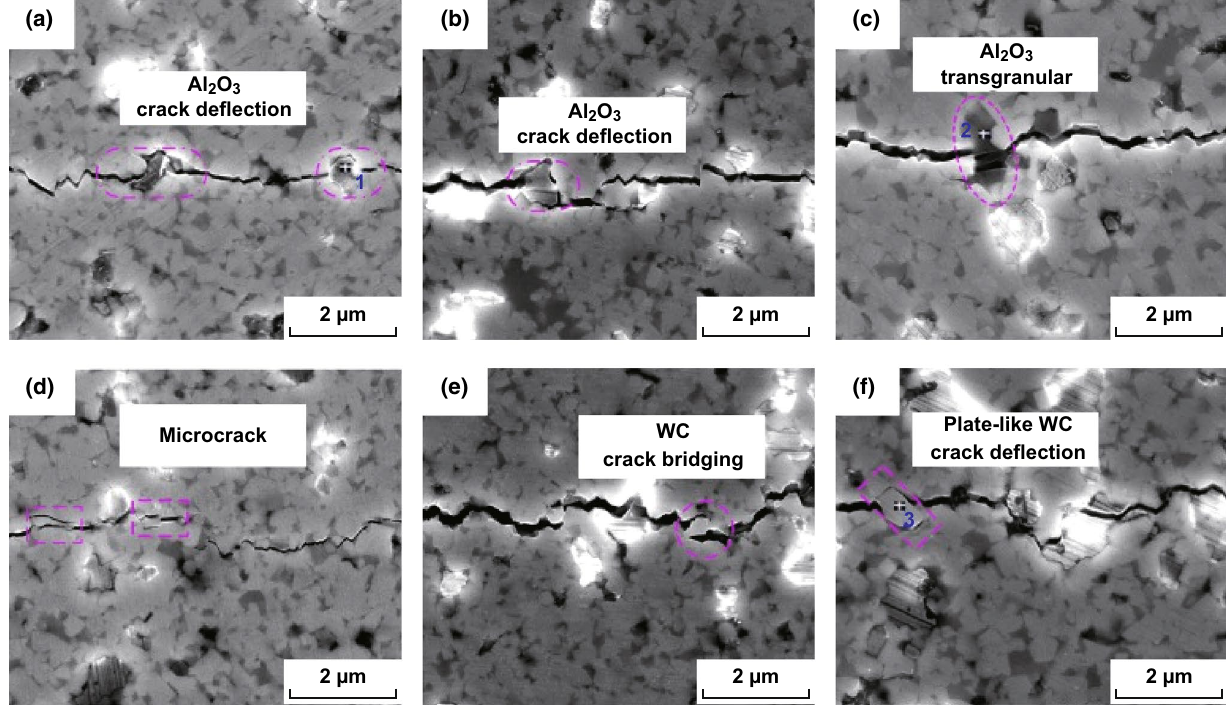
Fig. 10 Toughening mechanisms in WC–Al 2 O 3 –TiC ceramics: a, b Al 2 O 3 crack deflection, c Al 2 O 3 transgranular, d microcracking, e WC crack bridging and f plate‑like WC crack deflection [138]. Figure panels reproduced from Ref. [138] Elsevier copyright